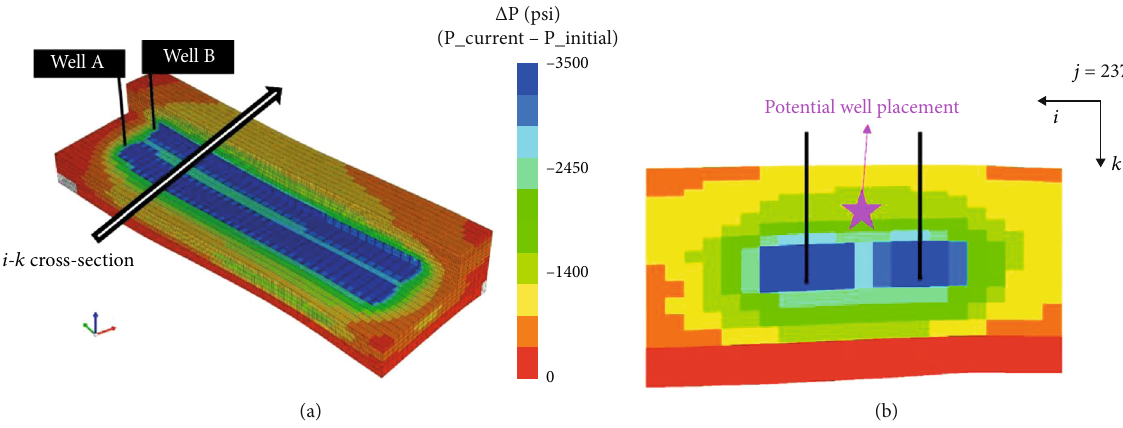
Figure 15: Pressure change of the history-matched model after 1 year: (a) 3D model view and (b) i - k cross-section view.